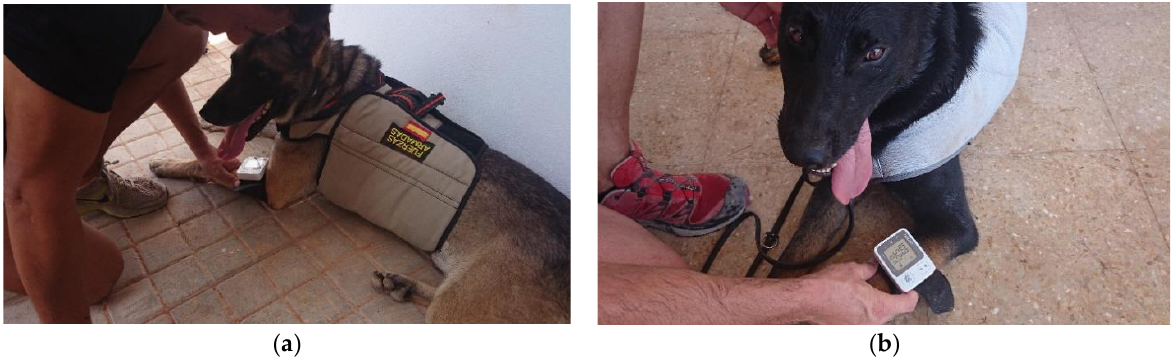
Figure 2. Non-invasive systemic blood pressure measurement in dogs immediately after exercise ( a ) with PCM-Cooling vest (by contact with cold tablets) and ( b ) evaporation cooling vest.